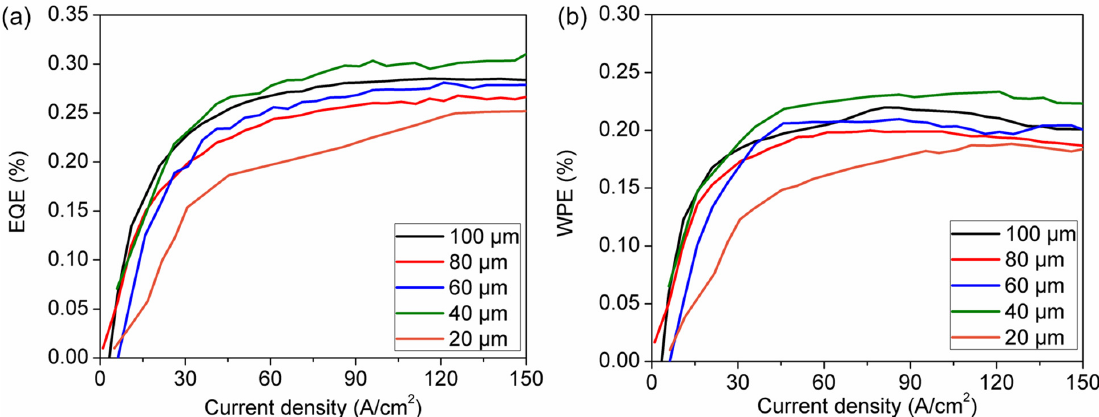
Figure 4. The dependence of ( a ) EQE and ( b ) WPE with the current density of packaged red InGaN devices.